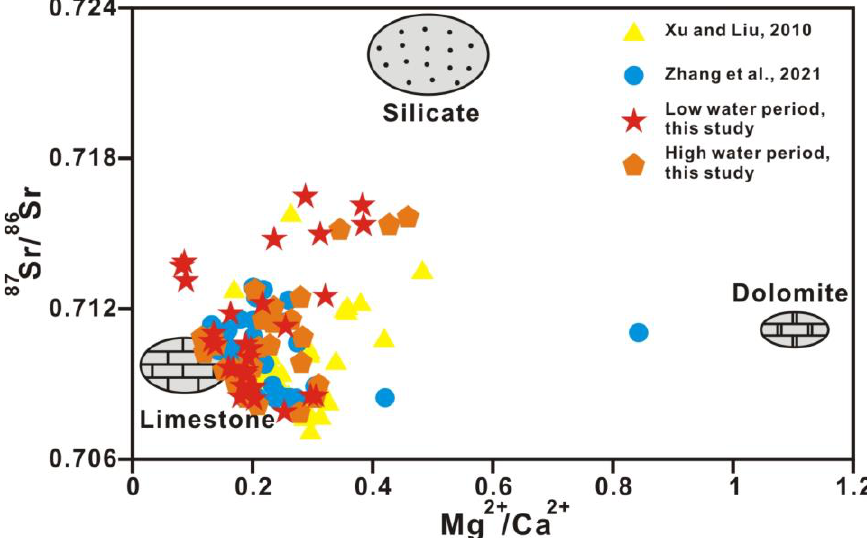
Figure 7. Plots of the molar ratio of Mg 2+ /Ca 2+ versus the molar ratio of Na + /Ca 2+ (after correction for atmospheric input based on Han et al., 2010b) in Xi River drainage waters [41]. Rock end-members are from Han et al., 2004 [44]. The data distribution area of the 61 large rivers of the world is based on the data compiled by Gaillardet et al., 1999 [11]. Refs. (Gao et al., 2009; Sun et al., 2010; Xu and Liu, 2010; Jiang et al., 2018; Zhang et al.; 2021) are cited in figure [2,10,20,22,28].